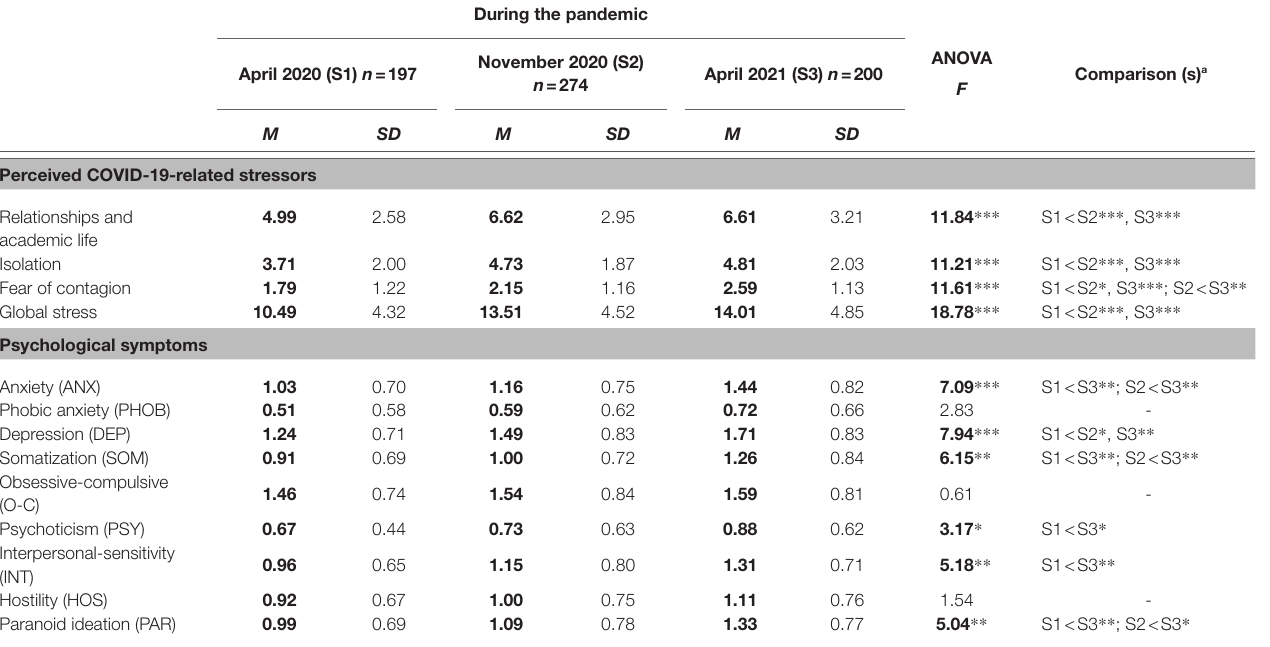
TABLE 2 | Descriptive statistics including means (M) and Standard Deviations (SD) for perceived levels of Coronavirus Disease 2019 (COVID-19)-related stressors and psychological health conditions across the three study stages during the pandemic. During the pandemic